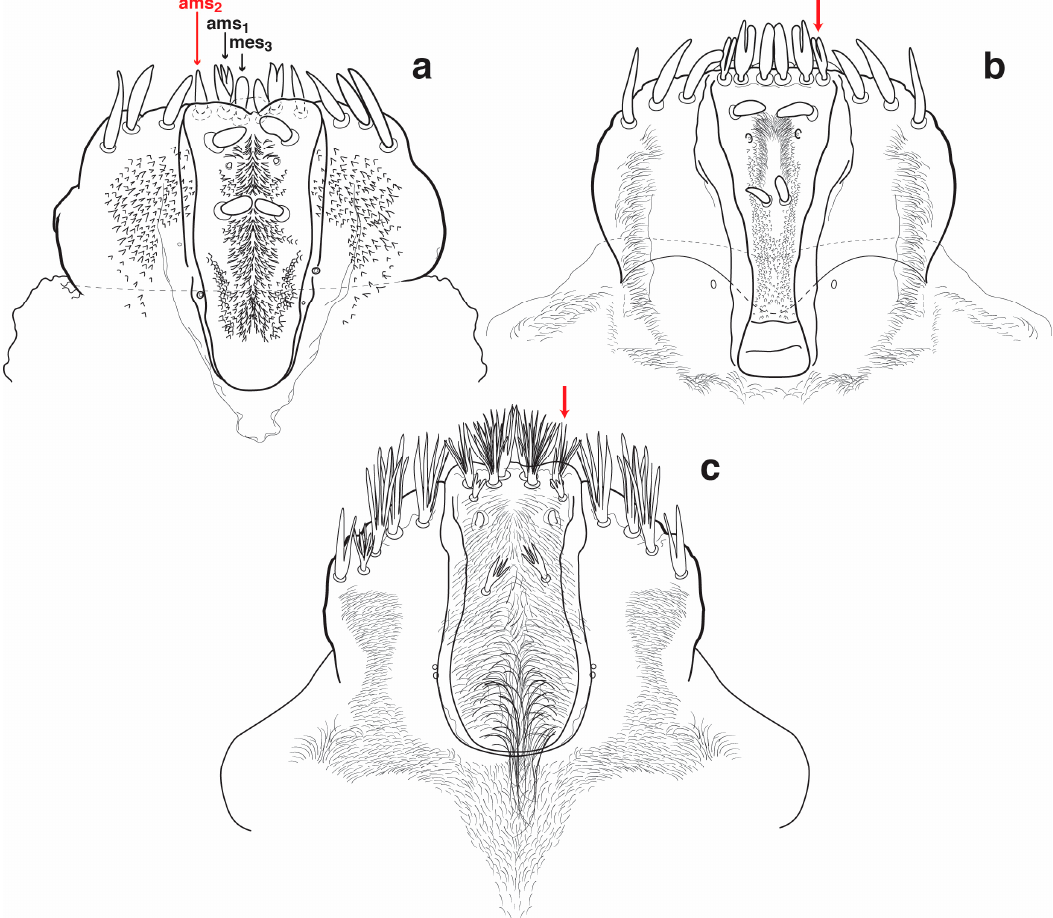
Figure 28. Epipharynx, larva: ( a ) Poteriophorus ; ( b ) Metamasius ; and ( c ) Yuccaborus. Mes3: median epipharyngeal setae; ams1, 2: anteromedian setae of epipharynx. 15. Relative length of ams1 and ams2 (Figure 29) a. Sub-equal Cactophagus, Diocalandra, Dryophthoroides [12], Dryophthorus, Eucalandra, Eugnoristus*, Foveolus, Mesocordylus (probably), Myocalandra, Nassophasis, Nephius (=Anius), Odoiporus, Paramasius, Polytus, Poteriophorus, Rhabdoscelus, Rhinostomus , Scyphophorus*, Sipalinus, Sitophilus, Sphenophorus, Stenommatus#, Trochorhopalus, Tryphetus, Yuccaborus b. ams1 approximately twice as long as ams2 Cyrtotrachelus , Diathetes, Eugnoristus* , Phacecorynes, Rhynchophorus, Scyphophorus* c. ams1 approximately 1/3 longer than ams2 Cosmopolites , Metamasius, Rhodobaenus, Temnoschoita Not included: Sparganobasis (broken/weathered) , Trigonotarsus (broken/weathered; maybe b/c), Xerodermus